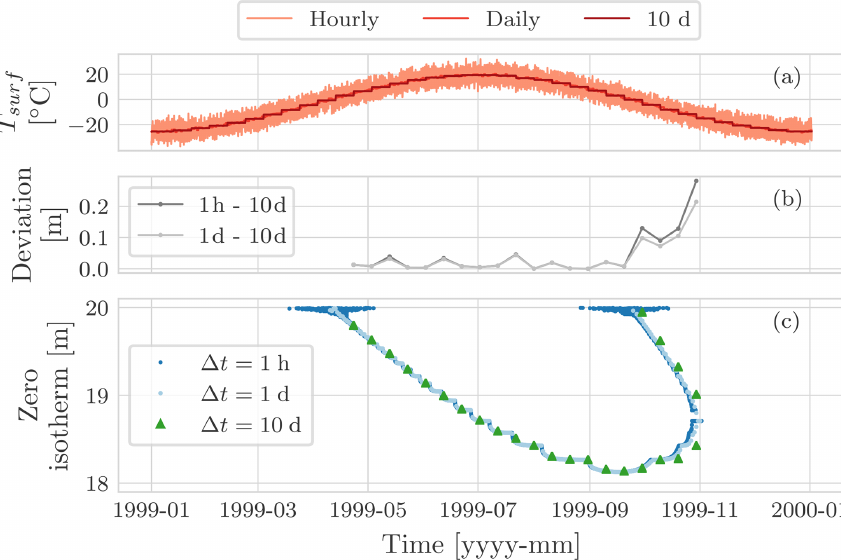
Figure G5. Comparison of the position of the zero isotherm, panel (c) , after 100 years of three simulations: using an hourly boundary condition with time step of (cid:49)t = 1h, using a daily boundary condition with a time step of (cid:49)t = 1d, and using a 10d boundary condition with a time step of (cid:49)t = 10d. Panel (a) shows the surface temperature for the hourly, the daily, and the 10d simulations. Panel (b) shows the deviation of the position of the zero isotherm after 100 years between the hourly and the 10d simulation, as well as between the daily and the 10d simulation. Panel (c) shows the position of the zero isotherm. It is interesting to note that all the three curves are characterized by the presence of some steps due to the usage of a coarser grid. This trend is independent of the size of the time step. Another consequence of this is that the joining of the downward and upward freezing front is not captured by the hourly or by the daily